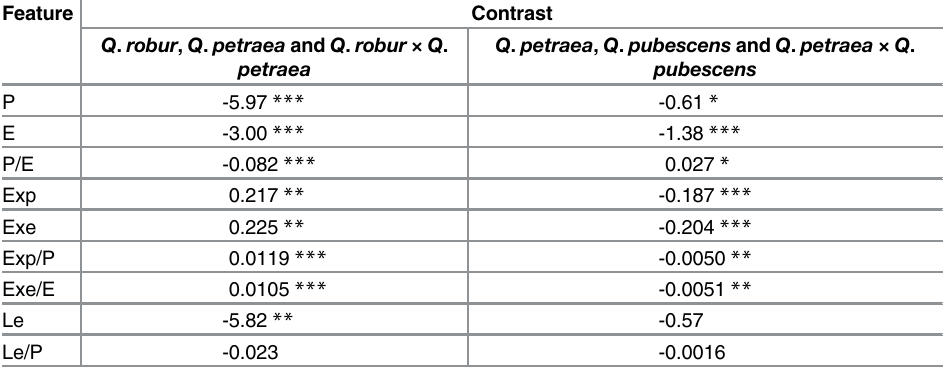
Table 6. Results of contrasts analysis between parental species and their hybrids.